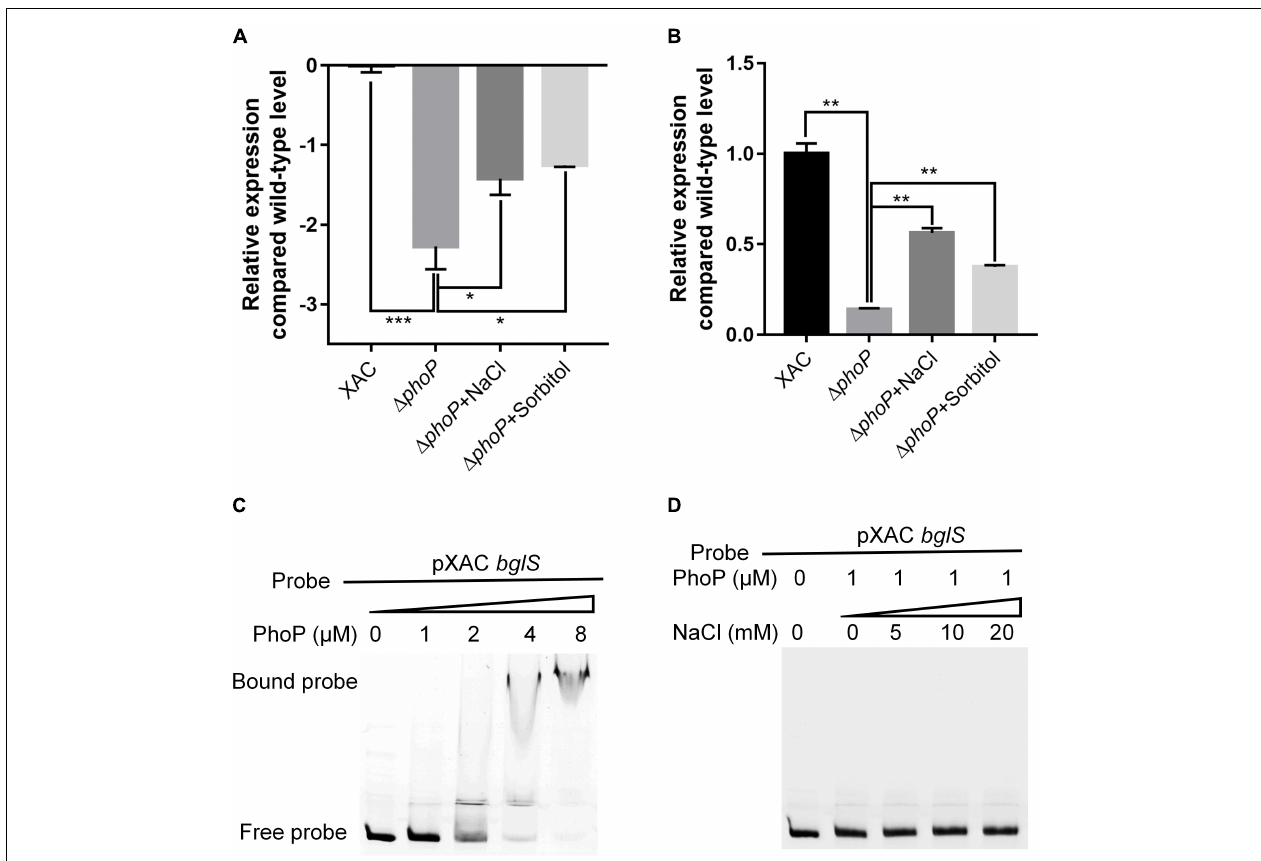
FIGURE 6 | X. citri PhoP directly bound bglS promoters. (A) Relative expression of bglS as determined by RNA-Seq. (B) Relative expression of bglS as determined by quantitative reverse transcription PCR. (C) Gel shift assay showing that PhoP directly bound the promoters of bglS . (D) Gel shift assay showing the effect of 0.05 M NaCl on PhoP binding of bglS promoters. PhoP (0, 1, 2, 4, or 8 µ M) were added to reaction mixtures containing 50 ng of probe DNA, and the reaction mixtures were separated on polyacrylamide gels. Error bars, means ± standard deviations ( n = 3). * P < 0.05, ** P < 0.01, *** P < 0.001, assessed by one-way ANOVA. Quantitative reverse transcription PCR and gel shift assay were repeated three times with similar